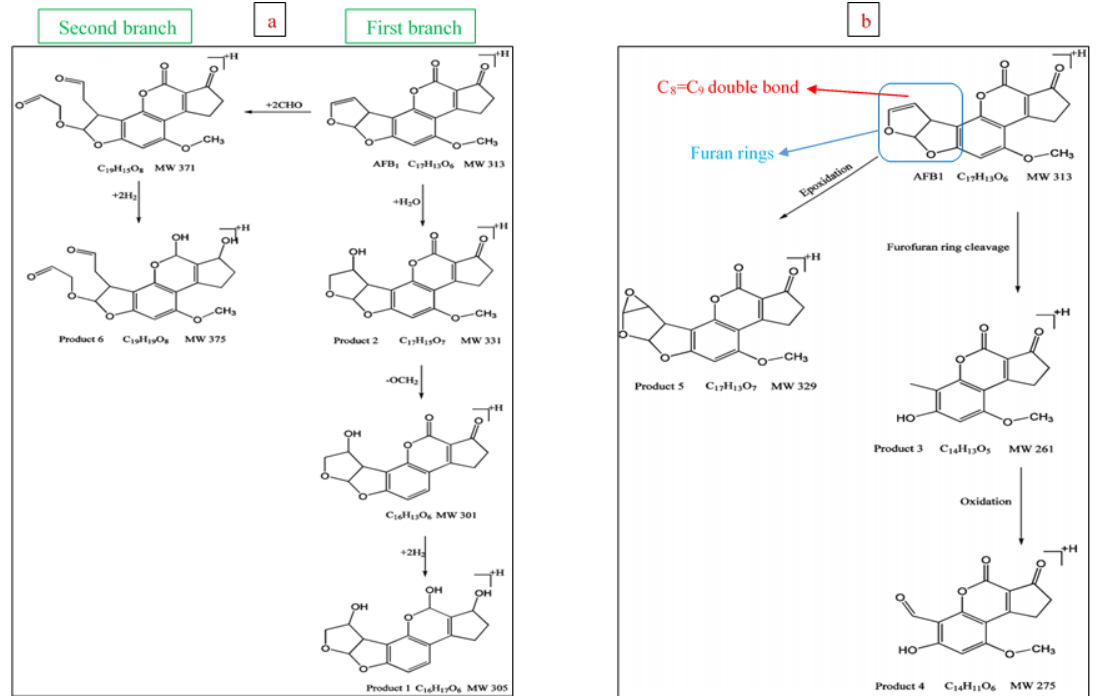
Figure 3. Degradation pathways ( a , b ) of aflatoxin B1 using non-thermal